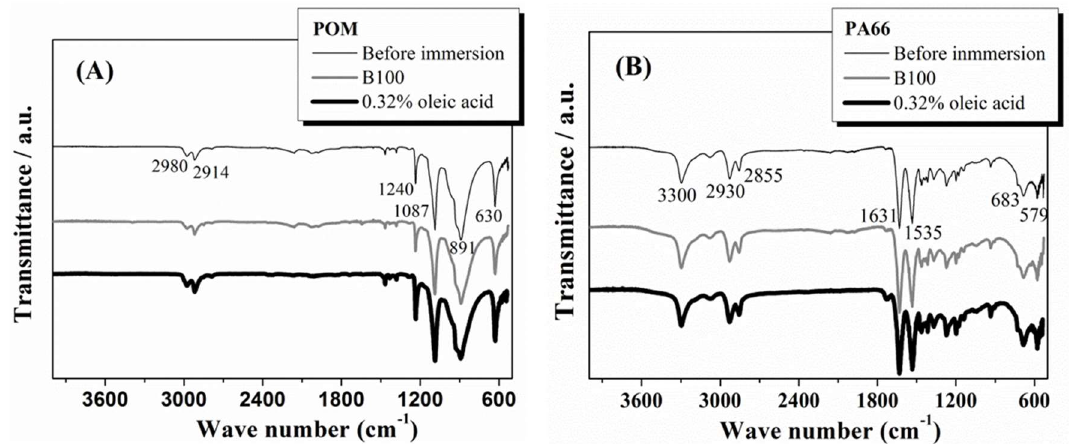
Figure 11. FTIR spectra for the ( A ) POM and ( B ) PA66 samples performed before and after immersion in B100 and B100–oleic acid blend.